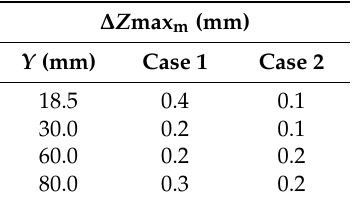
Figure 4. Comparison of measured hardness values vs. depth on the YZ symmetry plane for four different analyzed cases at Y : ( a ) 18.5 mm; ( b ) 35.0 mm; ( c ) 60.0 mm; and ( d ) 80.0 mm.